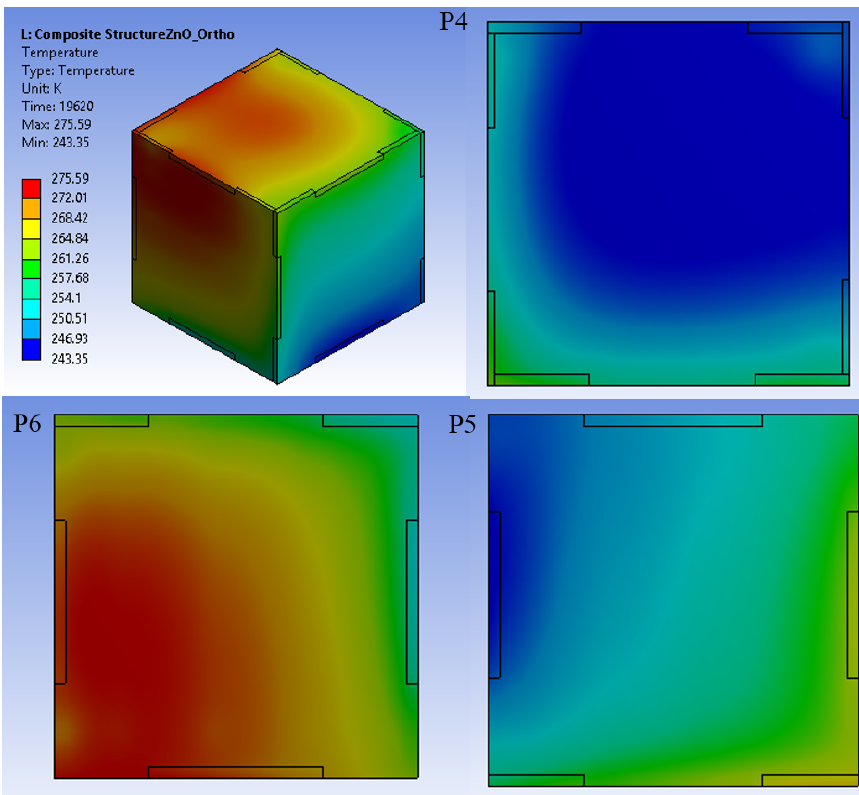
Figure 4. Temperature field on the surface of the CubeSat panels at t = 19,620 s ( β = 57 ◦ ).